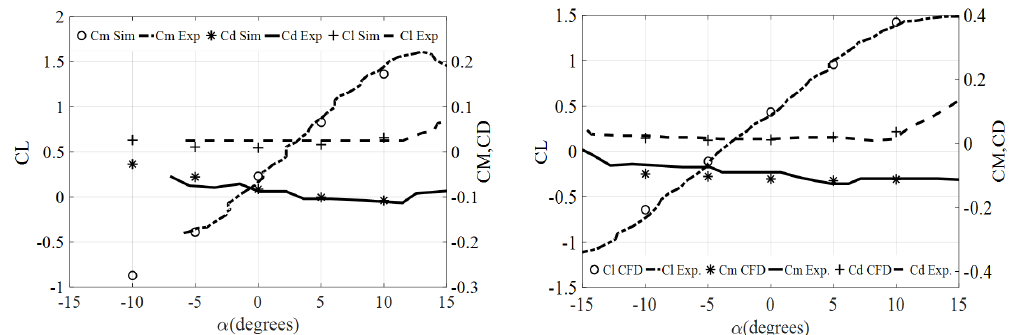
Figure 6. The aerofoil data for DU 35 ( left ), and NACA 64 ( right ).